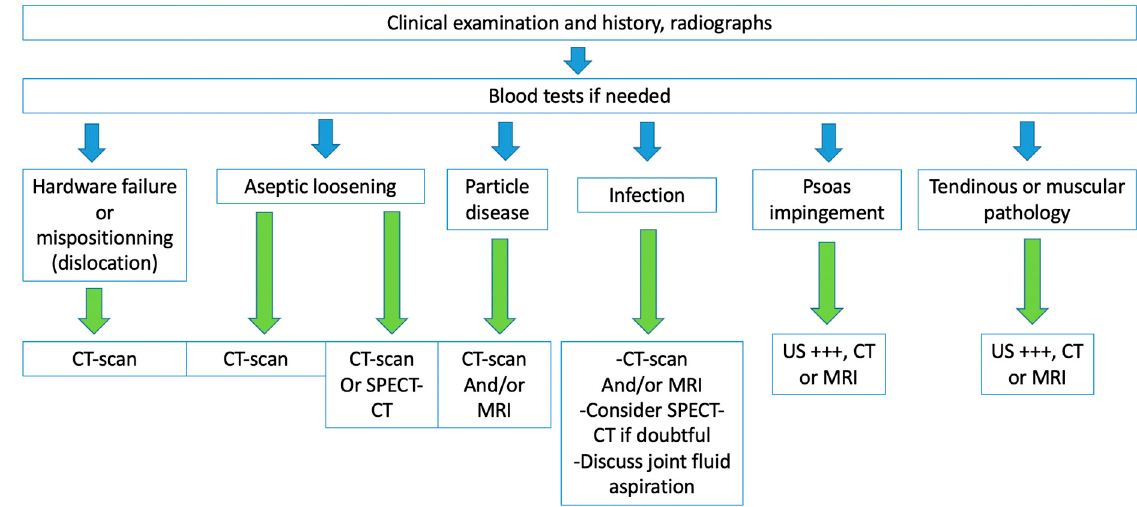
Figure 15. Imaging diagnostic algorithm proposition, adapted from Blum et al. [80,81].